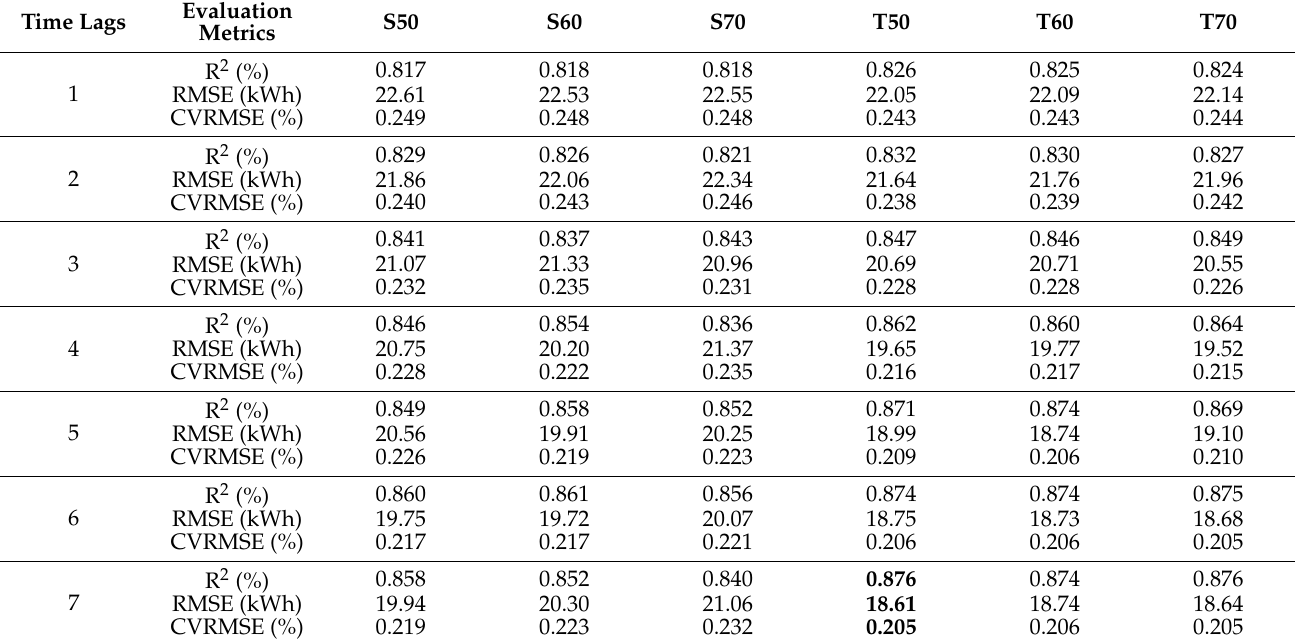
Table 4. Performance in the metrics evaluated when forecasting the energy consumption of the HVAC, using different time lags and HPs, applying the C1 configuration.